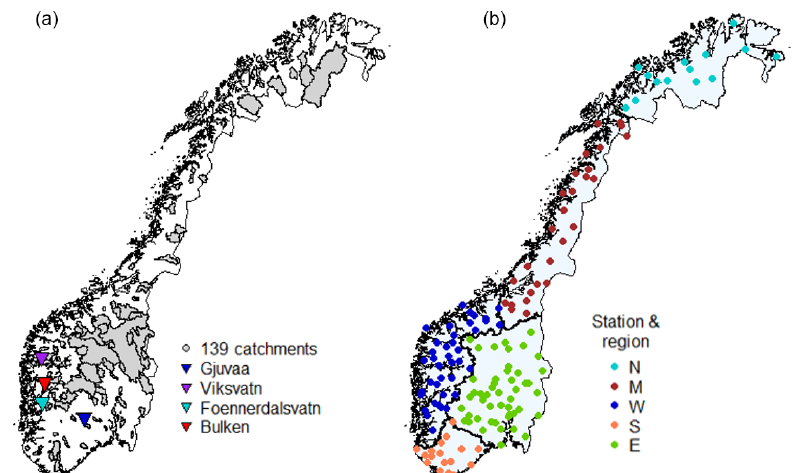
Figure 1. The maps for Norway indicate the 139 catchments used in this study. Panel (a) shows the catchment boundaries including the location of four selected catchments. Please note that many catchments are relatively small and difficult to detect. The locations of the catchment gauging stations are shown in (b) . Norway was grouped into five regions (N: north, M: middle, W: west, S: south, and E: east); all regions are marked with different colors and regional